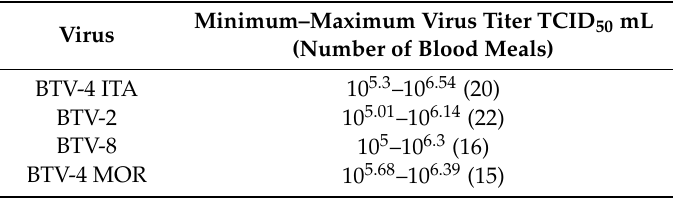
Table 2. Titers of bluetongue virus (BTV) strains in blood